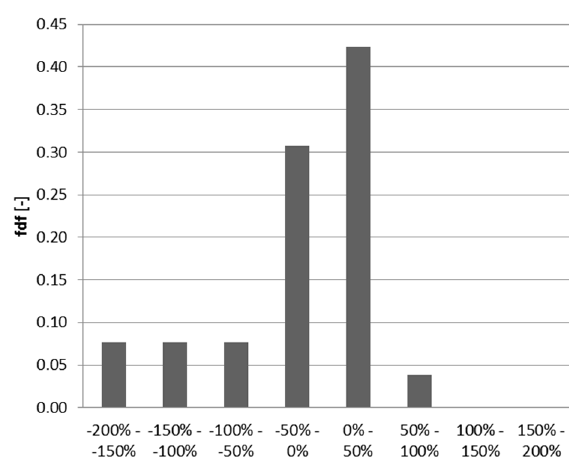
Figure 5. Relative frequency density function of the error between the sampled COD effluent concentration and the daily mean COD effluent concentration monitored by the online sensor. Data